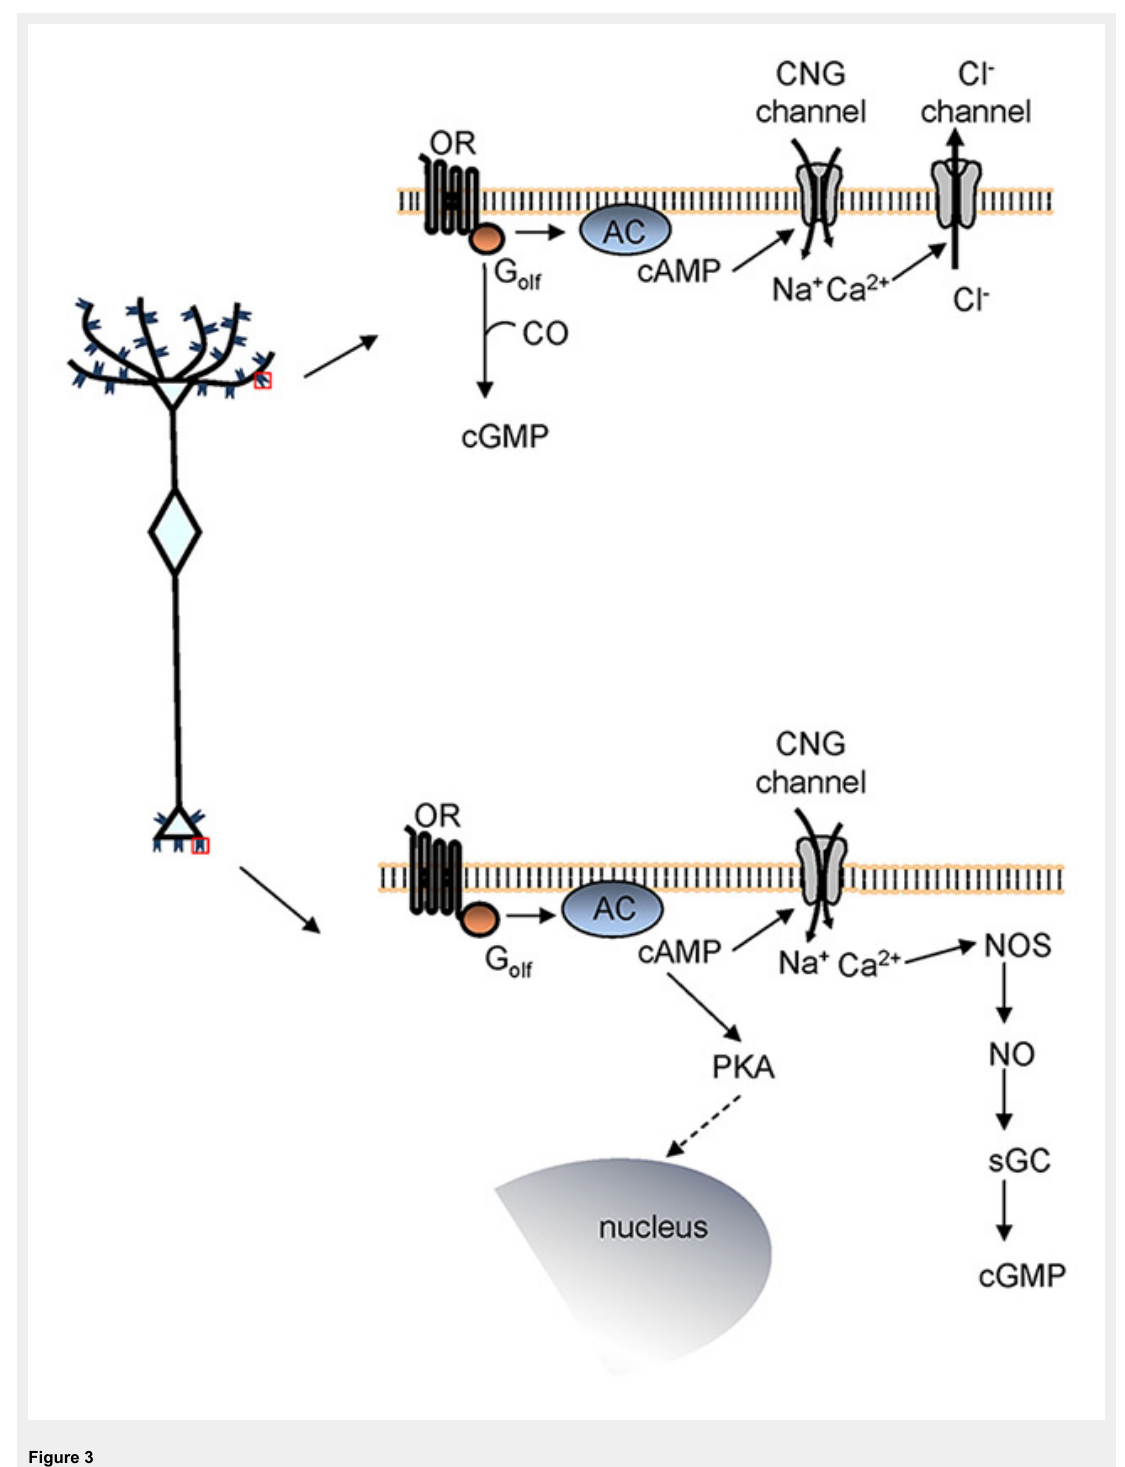
Figure 3 Signalling pathway coupled to the odorant receptor (OR). Left, schematic of an olfactory sensory neuron (OSN). Right, signalling pathway coupled to the OR expressed at the cilia (top) and at the axon terminal (bottom). AC = adenylyl cyclase; CNG channel = cyclic nucleotide-gated channel; CO = carbon monoxide; G olf = olfaction-specific G protein; ; NO = nitric oxide; NOS = nitric oxide synthase; PKA = protein kinase A; sGC = soluble guanylyl